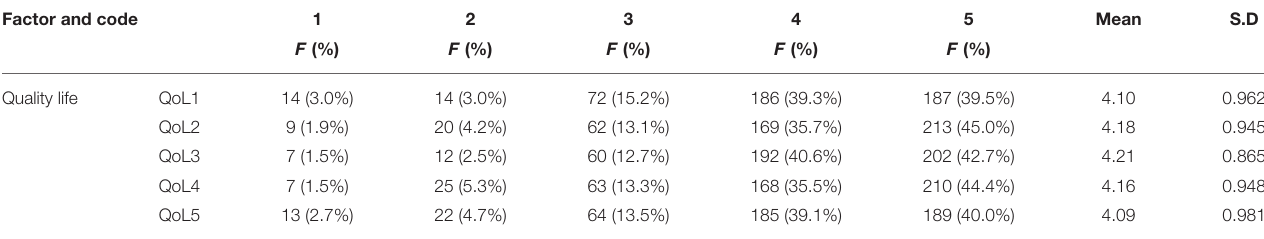
TABLE 8 | Measuring quality life (QoL).